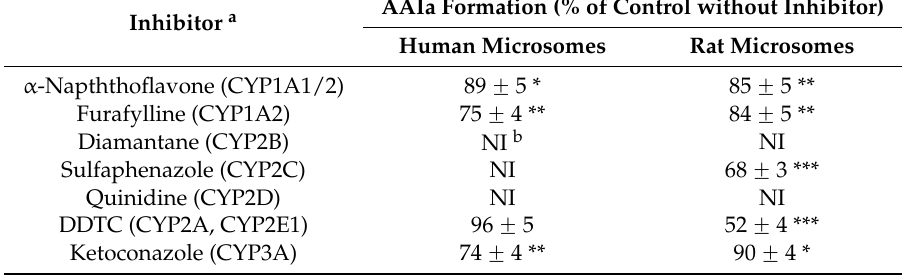
Table 1. Effects of cytochrome P450 (CYP) inhibitors on AAI oxidation to aristolochic acid Ia (AAIa) by human and rat liver